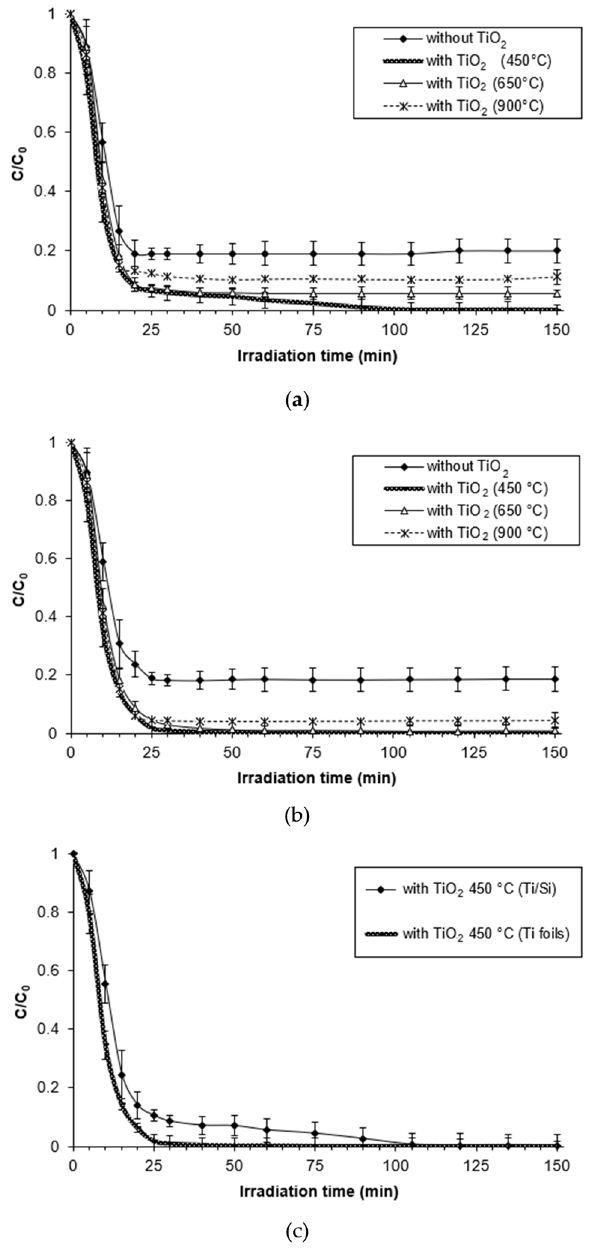
Figure 3. Photocatalytic activity of the TiO 2 samples annealed at various temperatures for the degradation of PNA in water: ( a ) with Ti deposed on Si substrate; ( b ) with Ti foil substrate; ( c ) Ti deposed on Si and Ti foils at 450 °C.